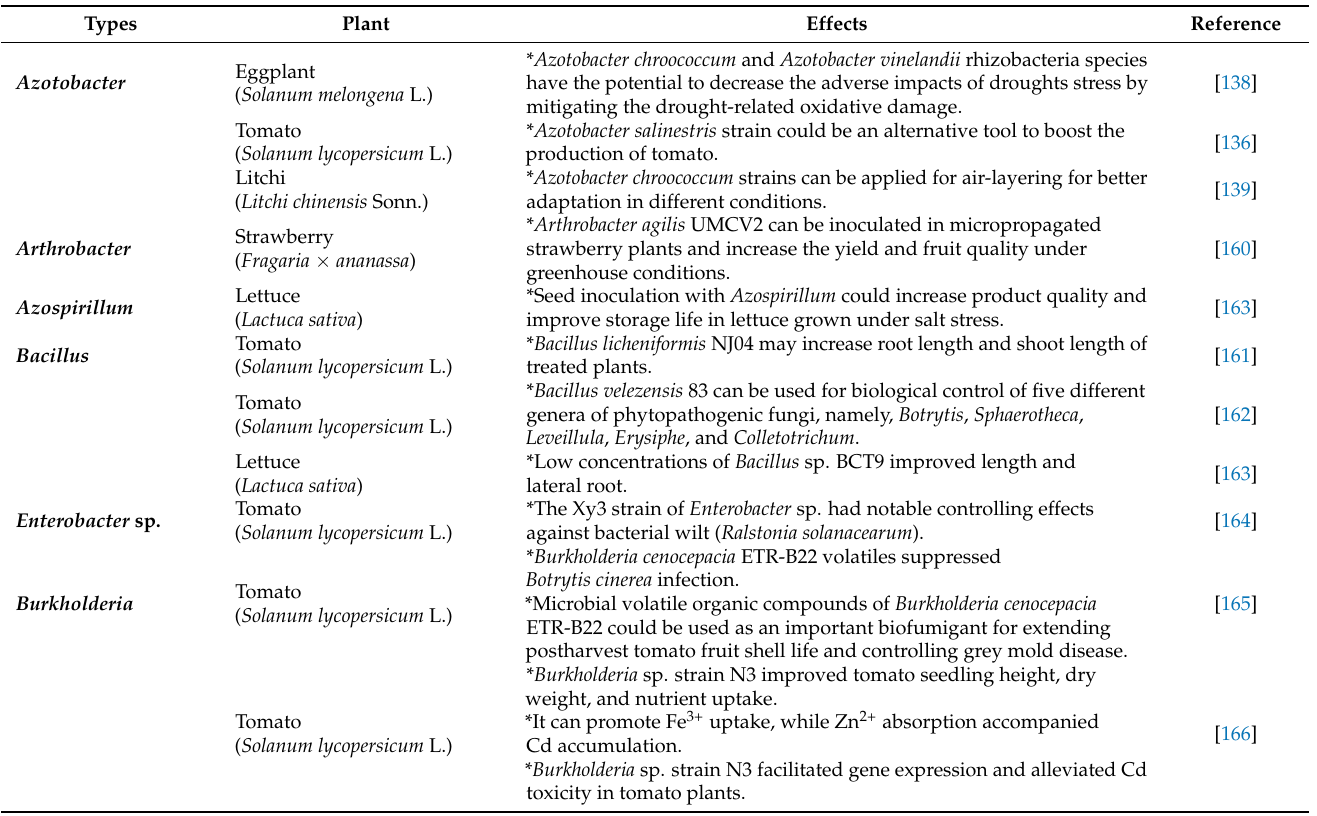
Table 2. The most important effects of PGPR on horticultural